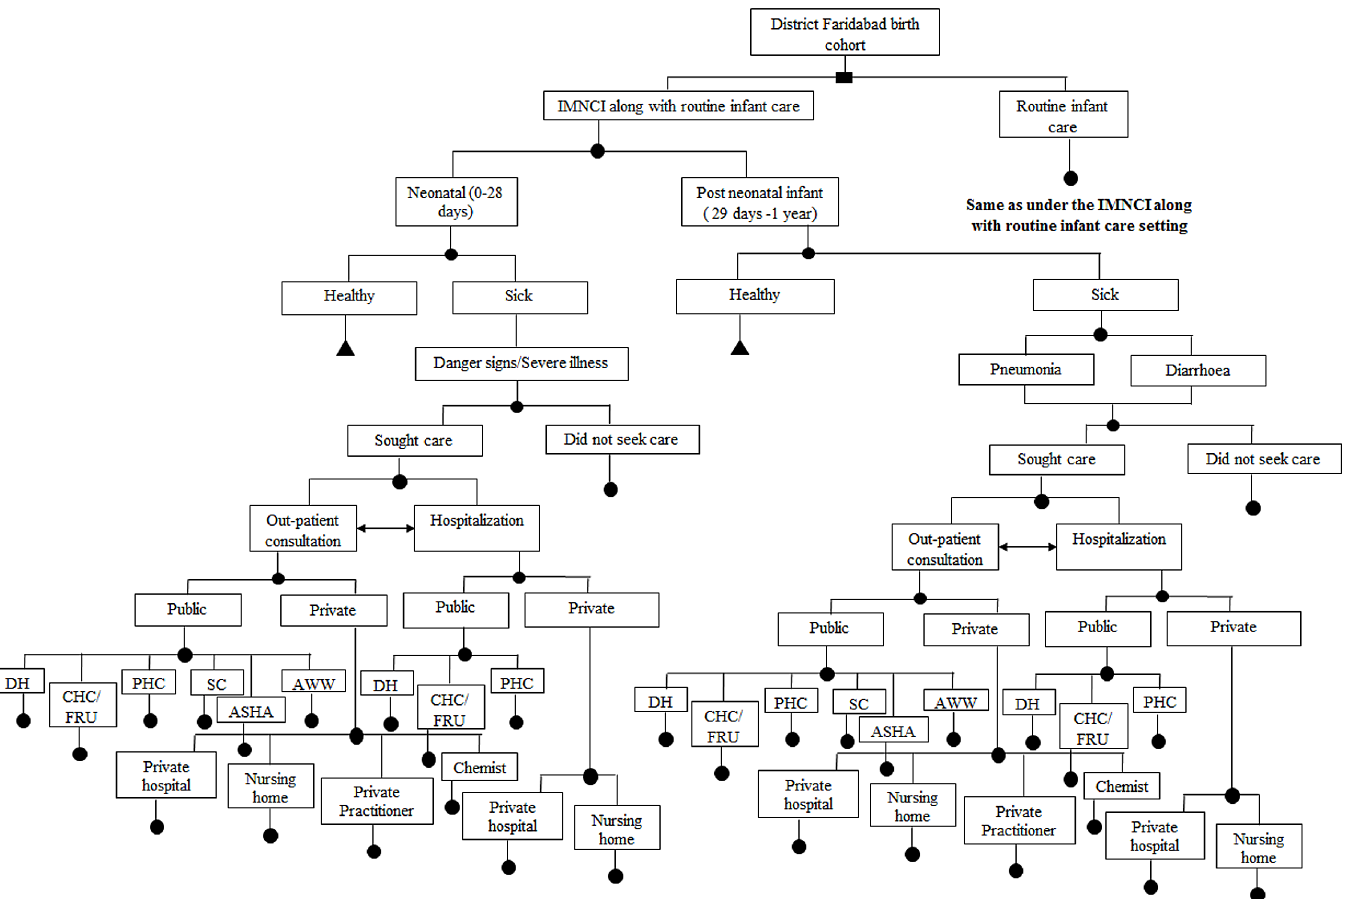
Fig 1. Decision Model for Cost-effectiveness of IMNCI in Haryana, India. Note : DH = District Hospital, CHC = Community health centre, FRU = First referral unit, PHC = Primary health centre, SC = sub-centre, ASHA = Accredited social health activist, AWW = Anganwadi worker. Cycle repeated for 15 birth cohorts (2008 –